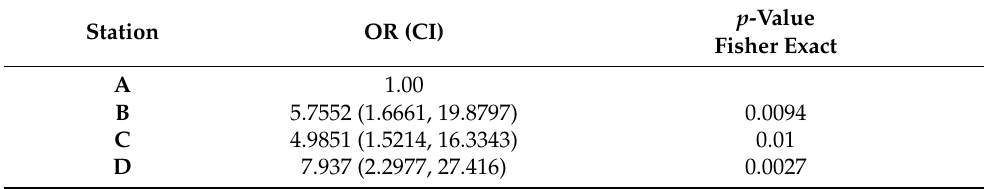
Table 9. Logistic regression models of rate of bacterial contamination per EMS call for FD2. OR = odds ratio. CI = confidence